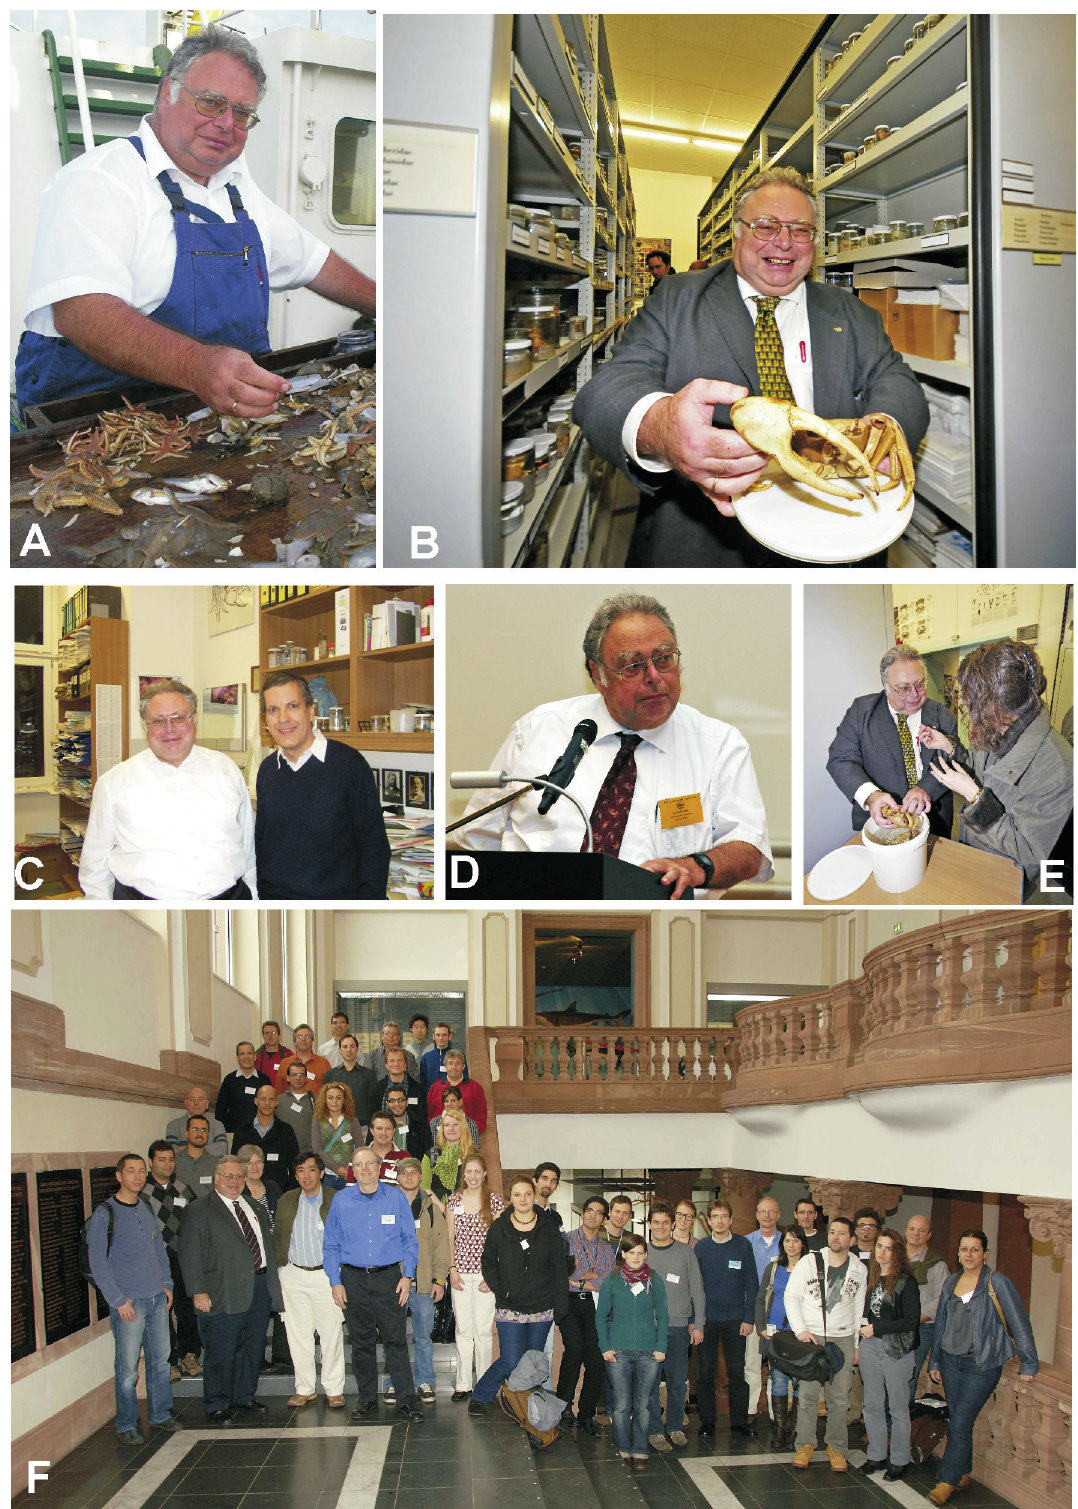
Figure 2. Michael Türkay, at different times of his professional life. A, sorting specimens on board of the RV Senckenberg , at the Dogger Bank, North Sea, 10 August 2008; B, in the crustacean collection of the Senckenberg Natural History Museum, 10 December 2010; C, with the author at his office, 16 February 2007; D, hosting the 8 th International Crustacean Congress in Frankfurt am Main, 20 August 2014; E, in the crustacean collection of the Senckenberg Natural History Museum, 10 December 2010; F, hosting the 21 st International Senckenberg Conference on Biology of Freshwater Decapods, Frankfurt am Main, 9 December 2010 (front row, second from the left). Photos: M. Sonnewald (A); O. Mengedoht (B, D–F); K. Sakai